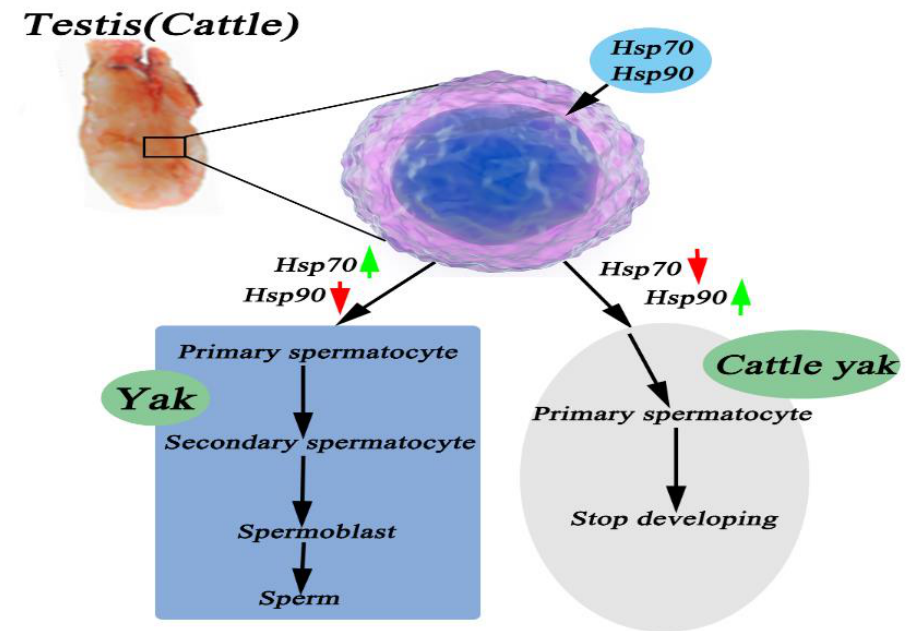
Figure 8. Hsp70 and Hsp90 schematic diagram of action mechanism in testicular tissues. The highly expressed Hsp90 could block development of primary spermatocyte in testis of cattle – yak.